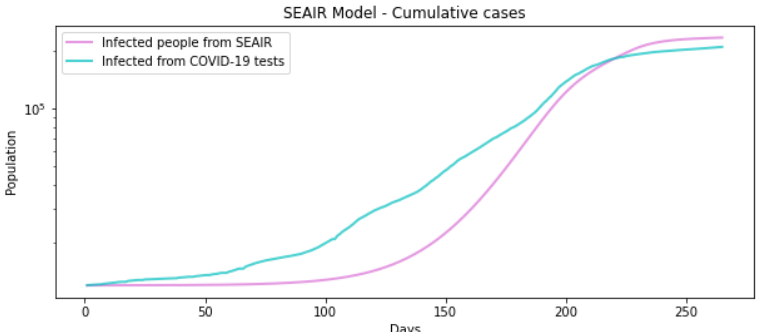
Figure 15. Comparison of cumulative infected people between SEAIR model and COVID-19 tests in Denmark’s second